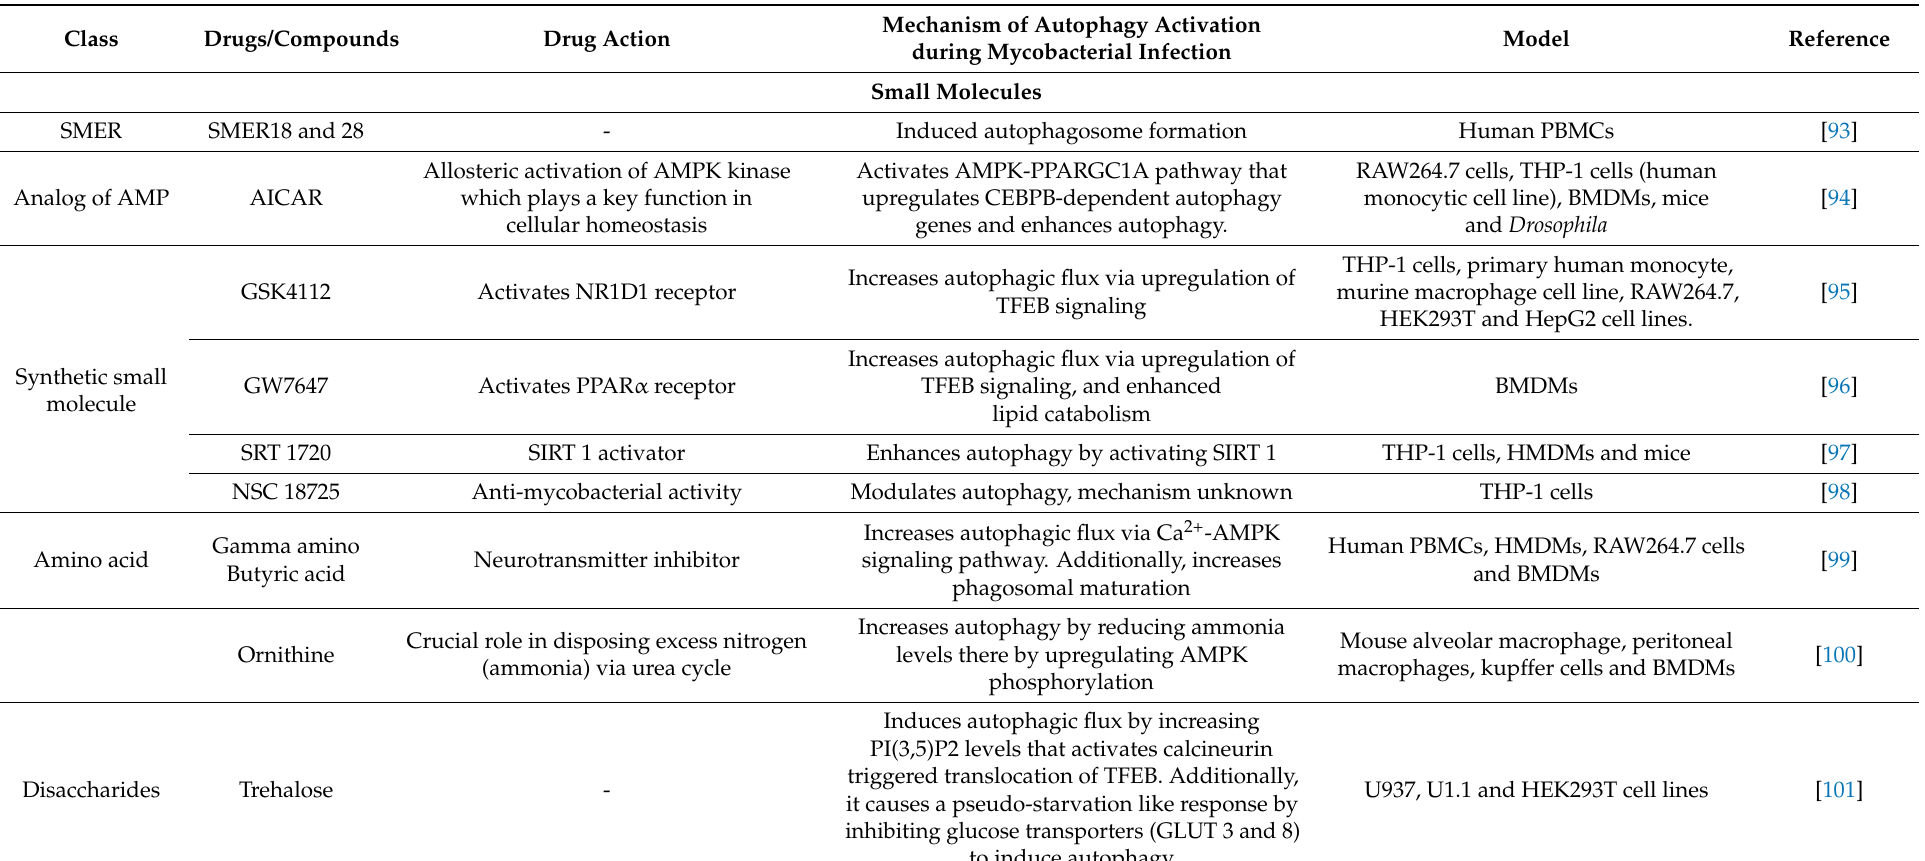
Table 1. List of potential host directed therapeutic agents targeting autophagy and their mechanism to aid antimycobacterial host